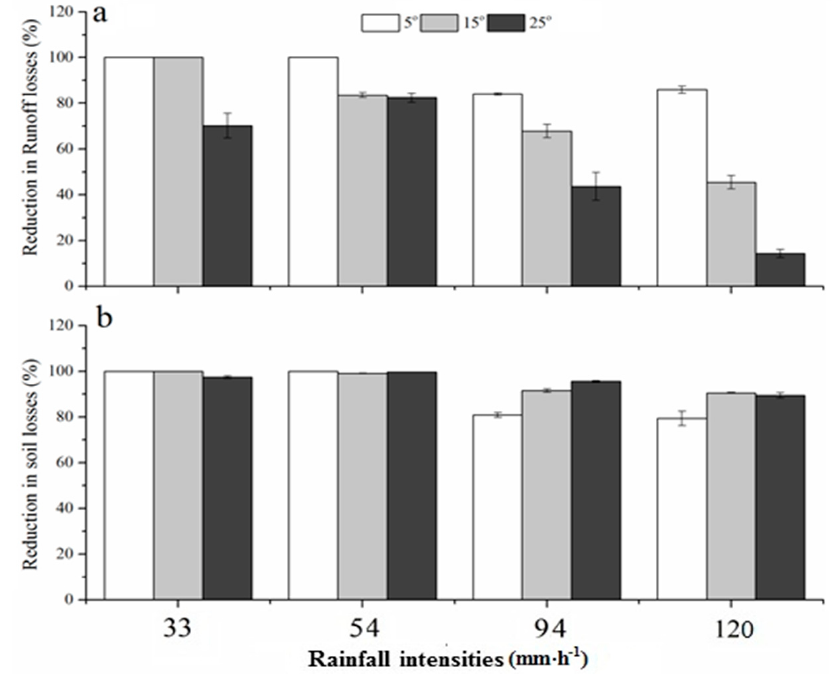
Figure 4. Conservation effectiveness of straw mulch on ( a ) runoff losses and ( b ) sediment losses from purple soil. Mean values ( n = 3) are given with standard deviation (S.D).